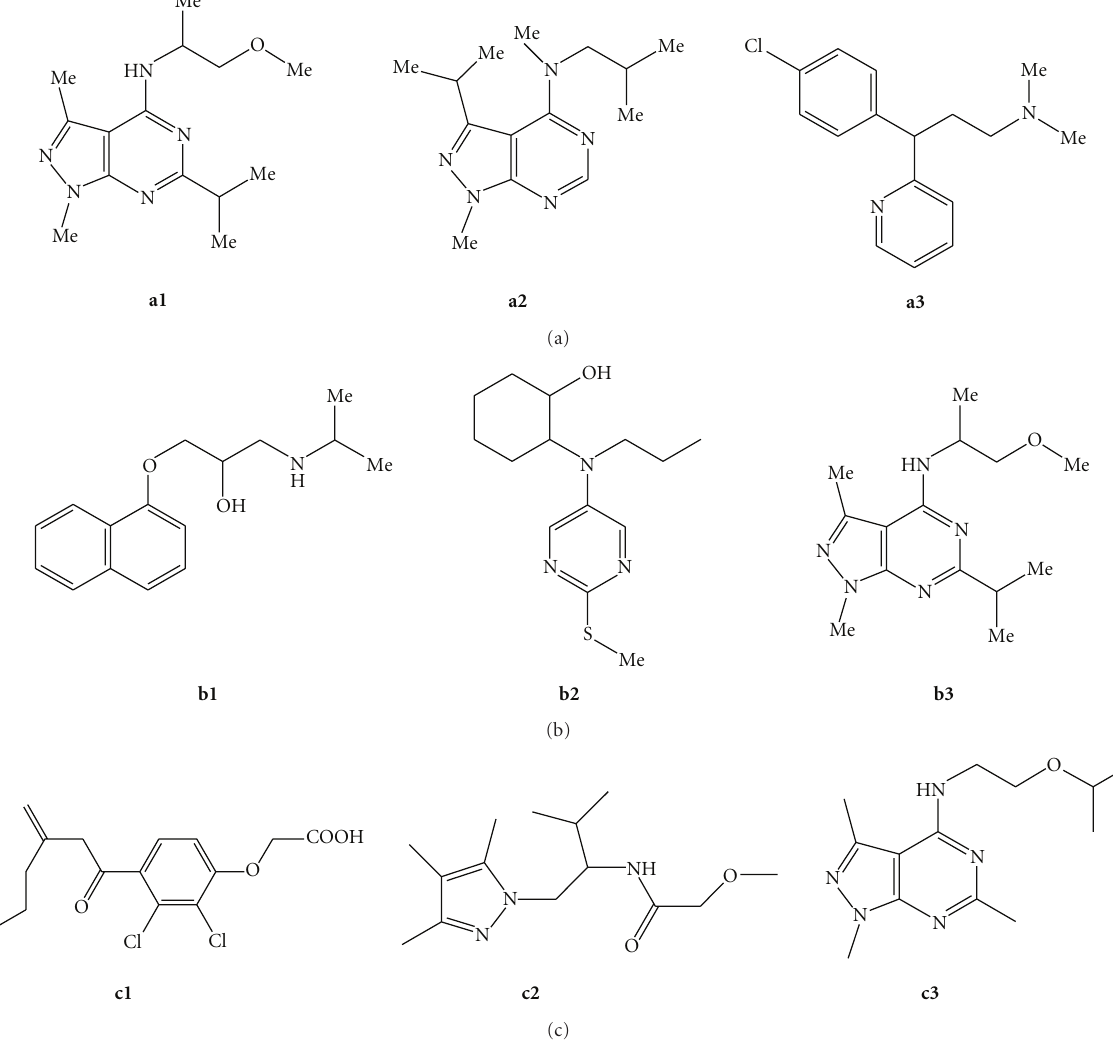
Figure 5: The three top-ranked compounds by the MGD method for the template: diphenhydramine. (a) The result with λ = 0 . 25. (b) The result with λ = 0. (c) The result with λ =